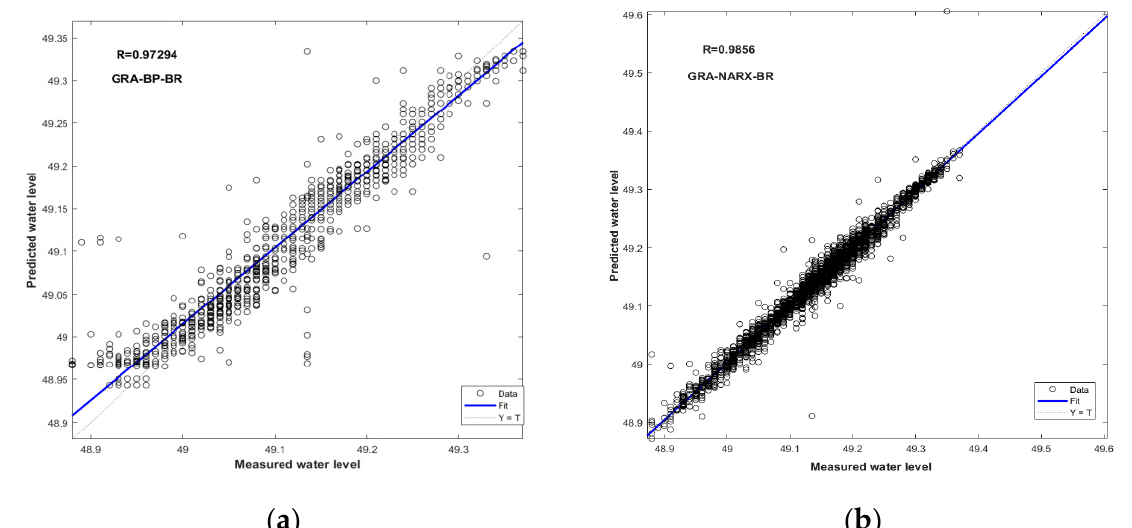
rithm, respectively.